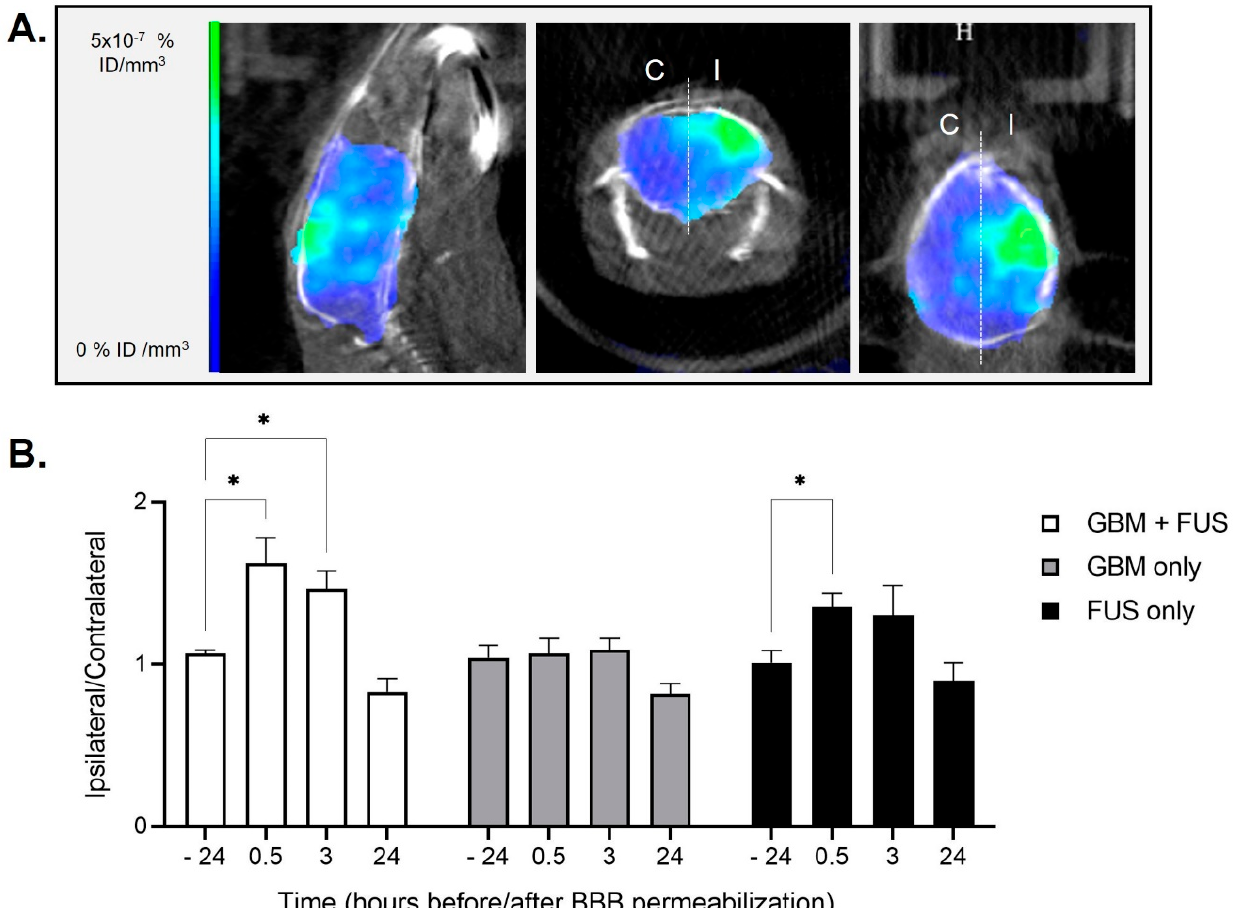
Figure 3. BBB permeabilization and [99mTc]Tc-DTPA SPECT/CT imaging on healthy and tumor-bearing animals. ( A ) Brain representative images obtained by [99mTc]Tc-DTPA-mediated SPECT/CT imaging in an animal of group “GBM + FUS” (tumor-bearing animals undergoing FUS-mediated BBB permeabilization) 0.5 h after hemispheric trajectory focused ultrasound. The white dotted line represents the separation between ipsilateral (I) and contralateral (C) brain hemispheres that was used for the quantifications; ( B ) Quantification of [99mTc]Tc-DTPA activity in animals of group “GBM + FUS” (tumor-bearing animals undergoing FUS-mediated BBB permeabilization, n = 5), group “GBM only” (tumor-bearing animals without FUS-mediated BBB permeabilization, n = 5) and group “FUS only” (healthy animals undergoing FUS-mediated BBB permeabilization, n = 4). Results are expressed as ipsilateral/contralateral ratio (mean ± SEM; * p <